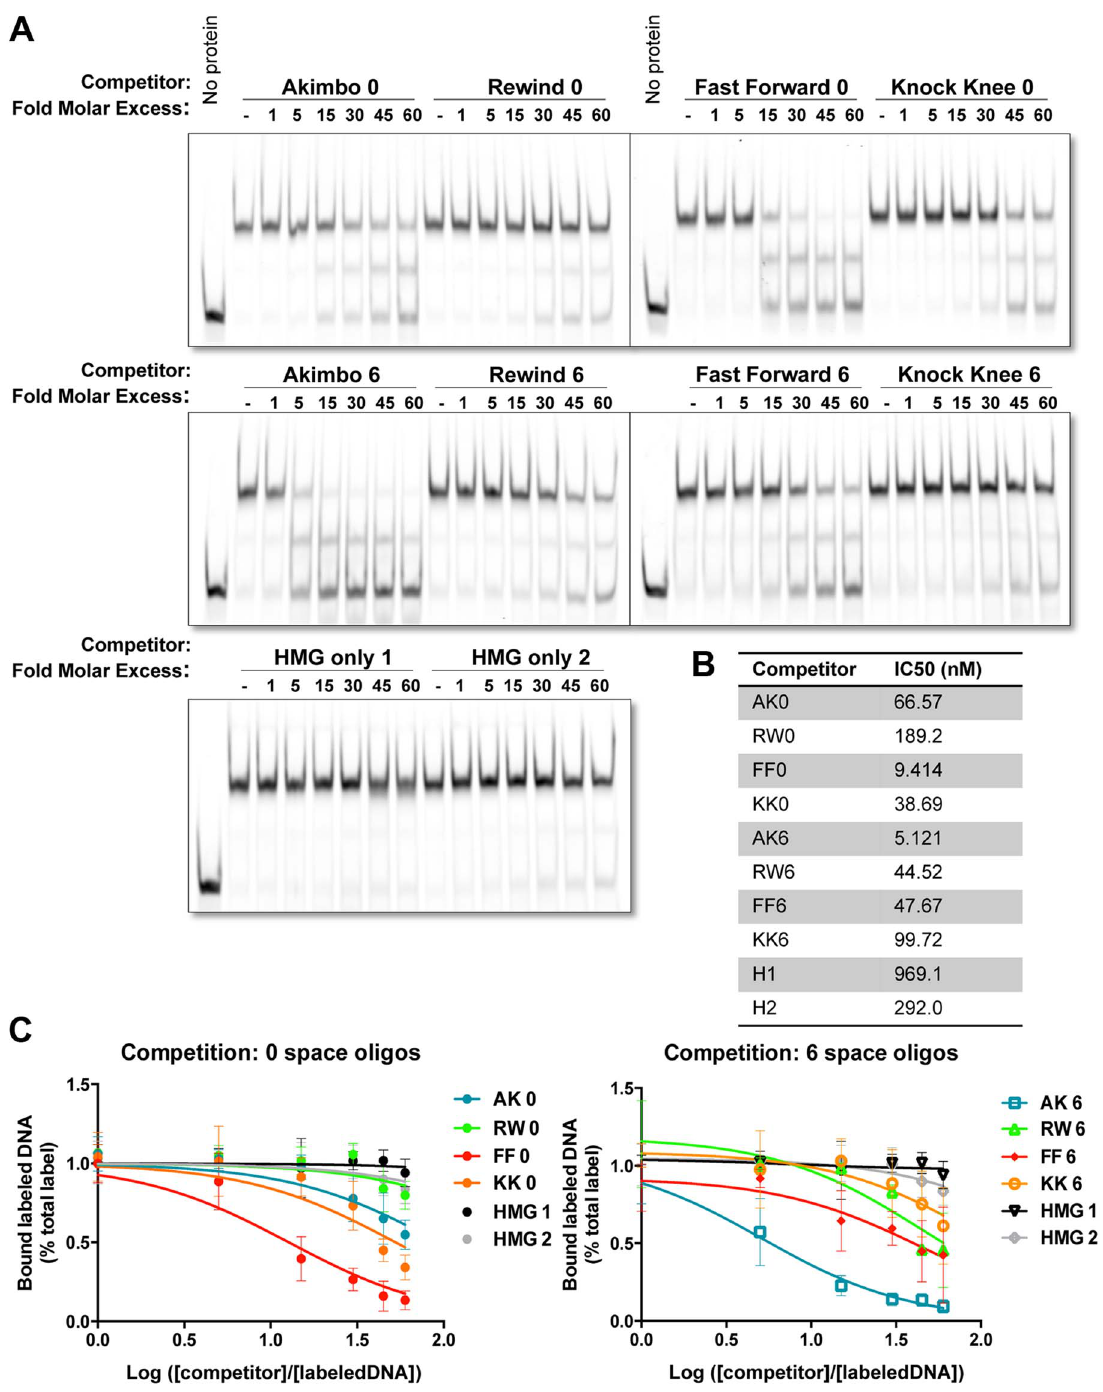
Figure 2. Binding preferences of TCF/Pan for various HMG-Helper site configurations invitro . (A) Competition electromobility shift assay (EMSA) experiments performed with a recombinant TCF fragment containing the HMG and C-Clamp domains, an AK6 IR-labeled probe, and competitor oligonucleotides containing one of the four orientations at 0 or 6 spaces. Images were taken on the Licor Odyssey, and binding intensity quantified with Image Studio 2.0. AK6 and FF0 were the strongest competitors, but Helper sites in all positions improve binding affinity when compared to binding of the HMG sites alone (HMG only 1 and 2). (B) The IC 50 value (the measure of DNA concentration required to reduce binding of the labeled probe to 50% of uncompeted levels) for each competitor was calculated using Prism 6.1 (Graphpad). (C) Semilog graphs depicting competition results from three independent experiments. Error bars indicate SD. Sequences of the HMG and Helper motifs the same as shown in Figure 1D (see Table S1 for full sequence of each competitor).